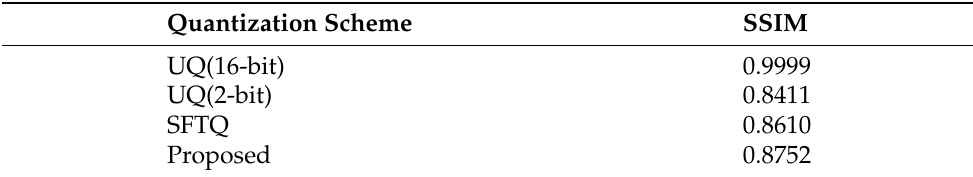
Figure 15. Imaging results of different quantization schemes. ( a ) Conventional 16-bit uniform quanti- zation. ( b ) Conventional two-bit uniform quantization. ( c ) SFTQ. ( d ) Proposed two-bit quantization. Table 2. SSIMs based on different quantization schemes.